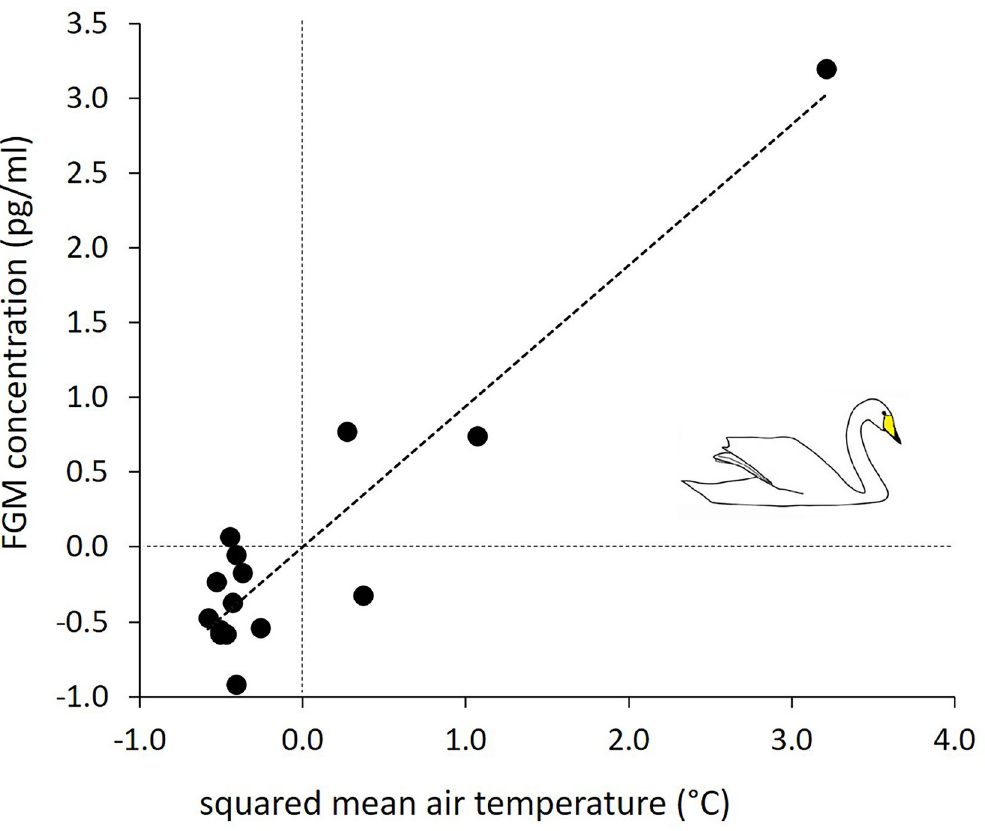
Figure 1. Best fitted non-linear regression model (Table 1), showing the relationship between FGM concentration, and squared mean air temperature (both z-transformed; R 2 =